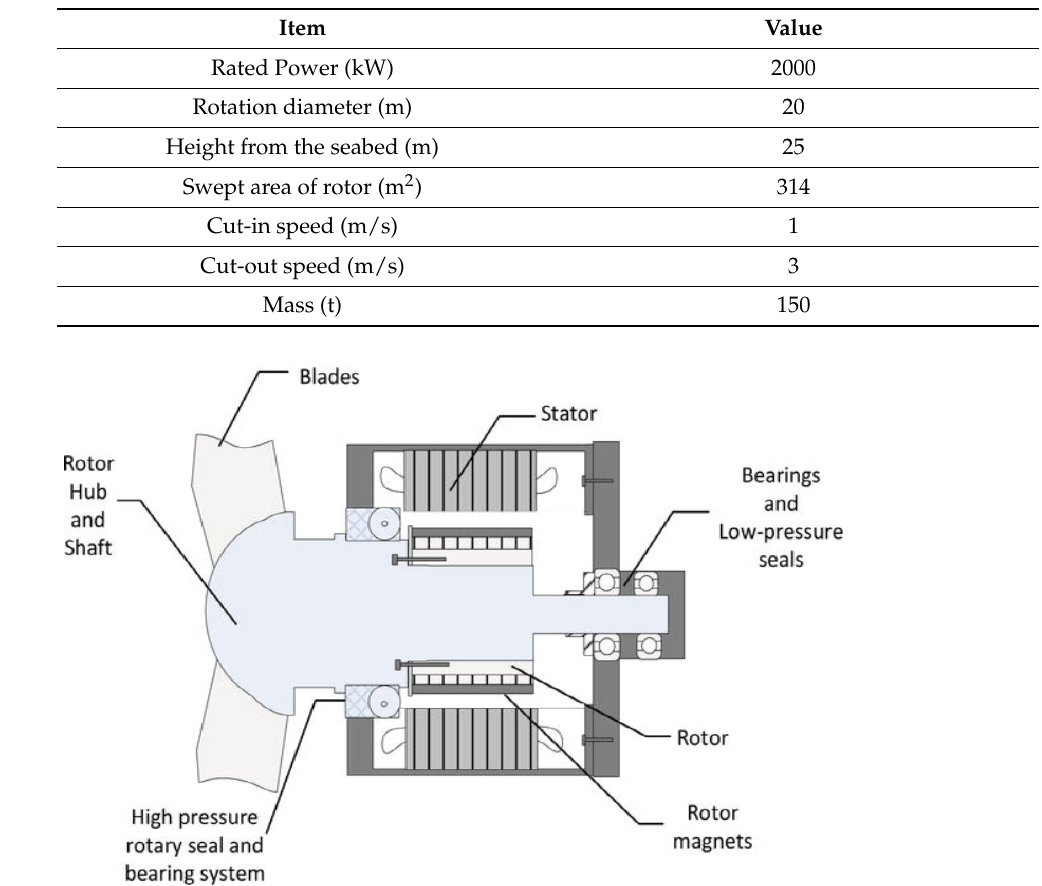
Figure 2. A sealed airgap direct-drive generator [8].